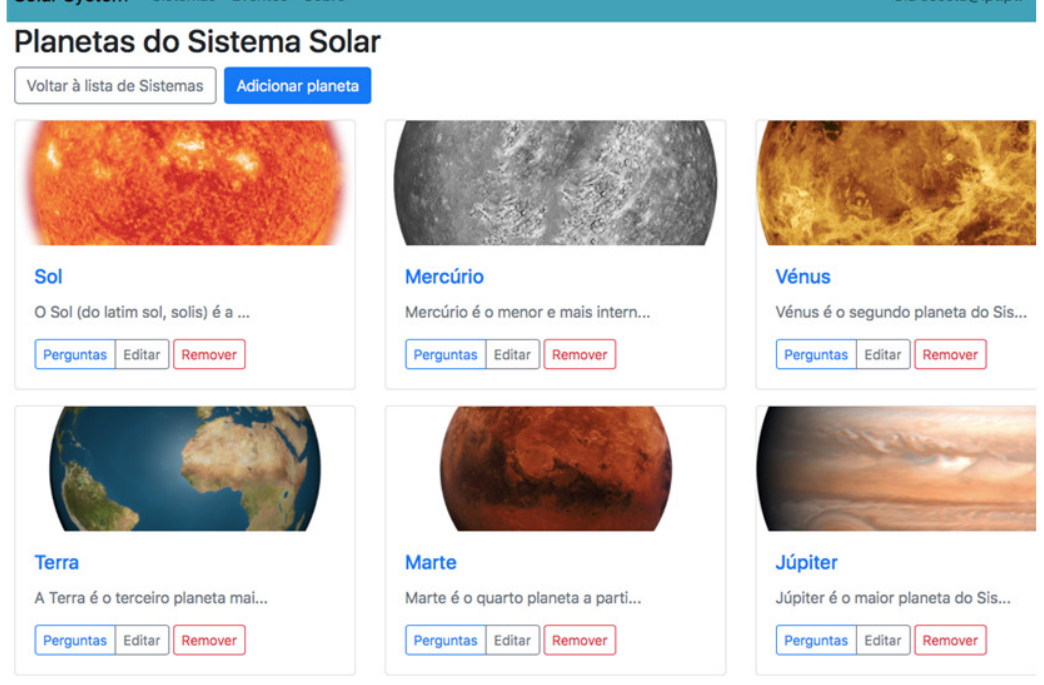
Figure 15. Excerpt of the repository that includes the Solar